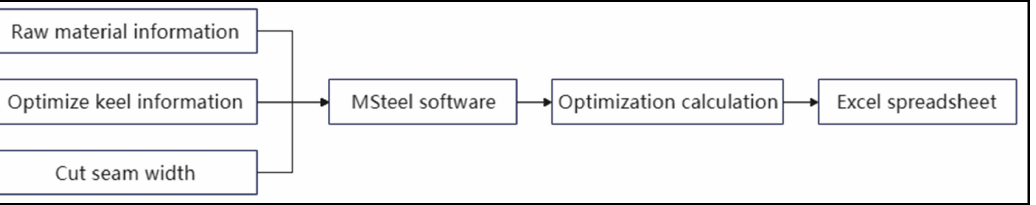
Figure 4. Forward-cutting optimization